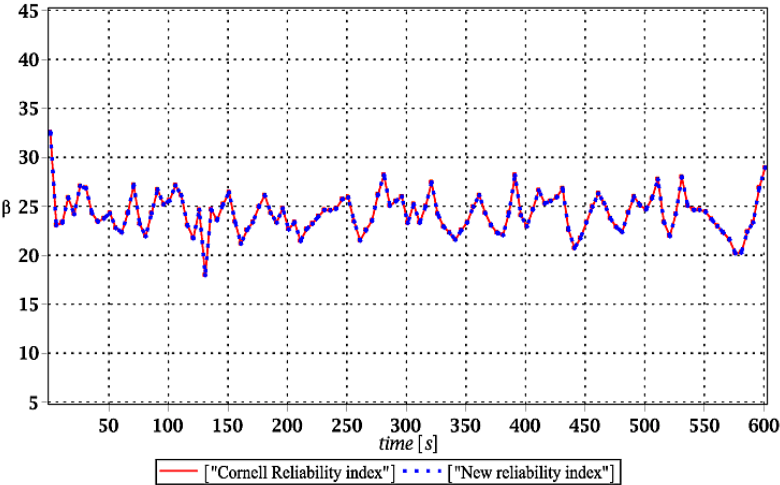
Figure 9. The comparison of dynamic reliability indices for uncertain wind pressure.